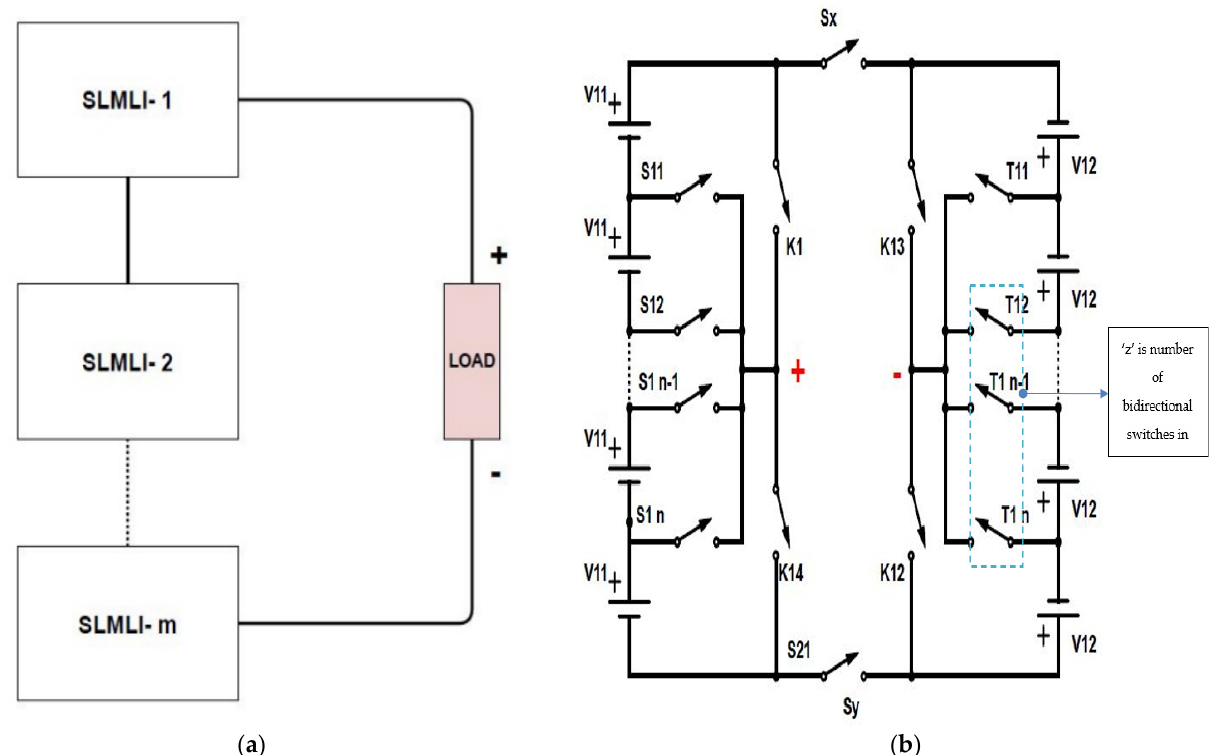
Figure 1. ( a ) Generalized structure of SLMLI [34]; ( b ) proposed SLMLI [34].